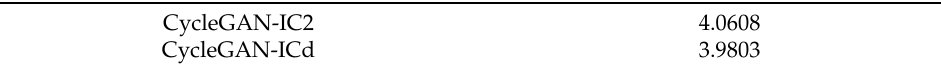
Table 7. The average MCD for MIR-QBSH-4 in singing to viola.